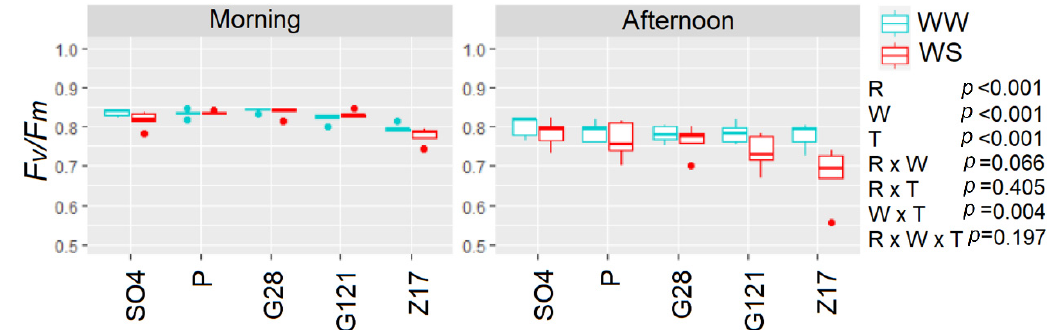
Figure 8. Maximum quantum yield of photosystem II (PSII) in dark adapted samples ( Fv / Fm ) carried out in all the rootstocks subjected to WW and WS ( n = 5). Data were recorded in the morning (average T 24 °C) and repeated in the afternoon (average T 41 °C) hence simulating heat stress conditions. The p -values from three-way ANOVA are shown in the graph.